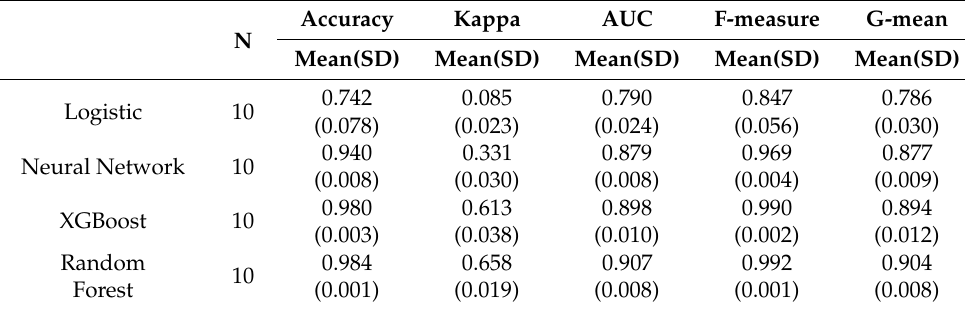
Table 5. The prediction performance of test